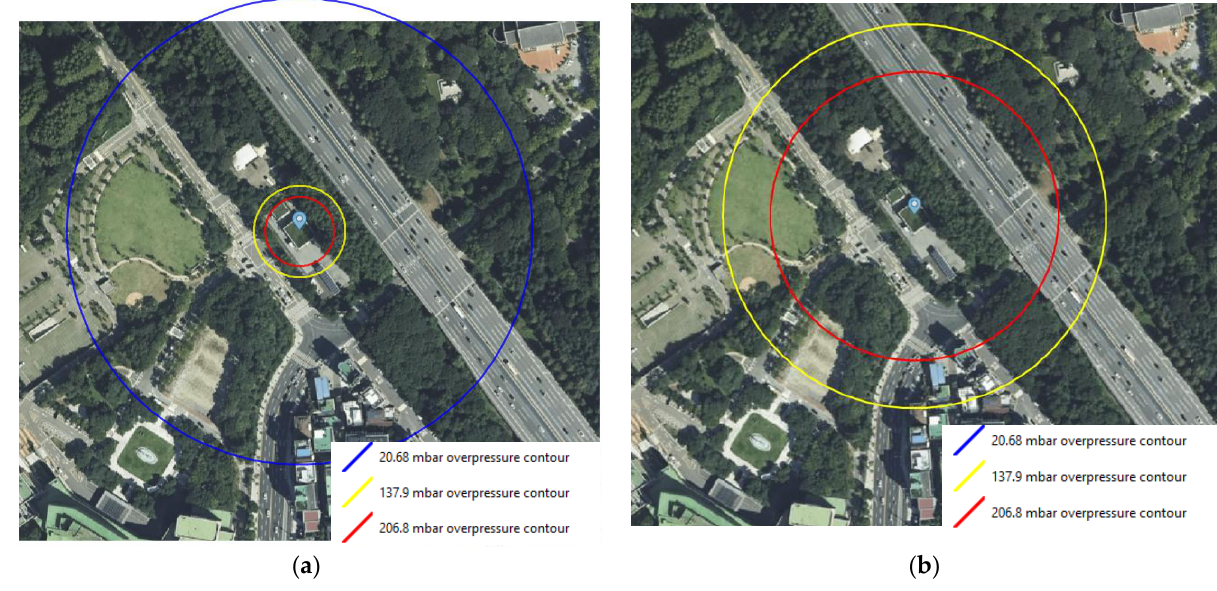
Figure 5. The overpressure contours for the ( a ) VCE of FAHRS due to the rupture of the H 2 buffer tank and ( b ) the VCE of GHRS due to the rupture of the H 2 tube trailer. The 20.68 mbar contour for the GHRS case extends beyond the boundary of the considered area and is not depicted in the figure.